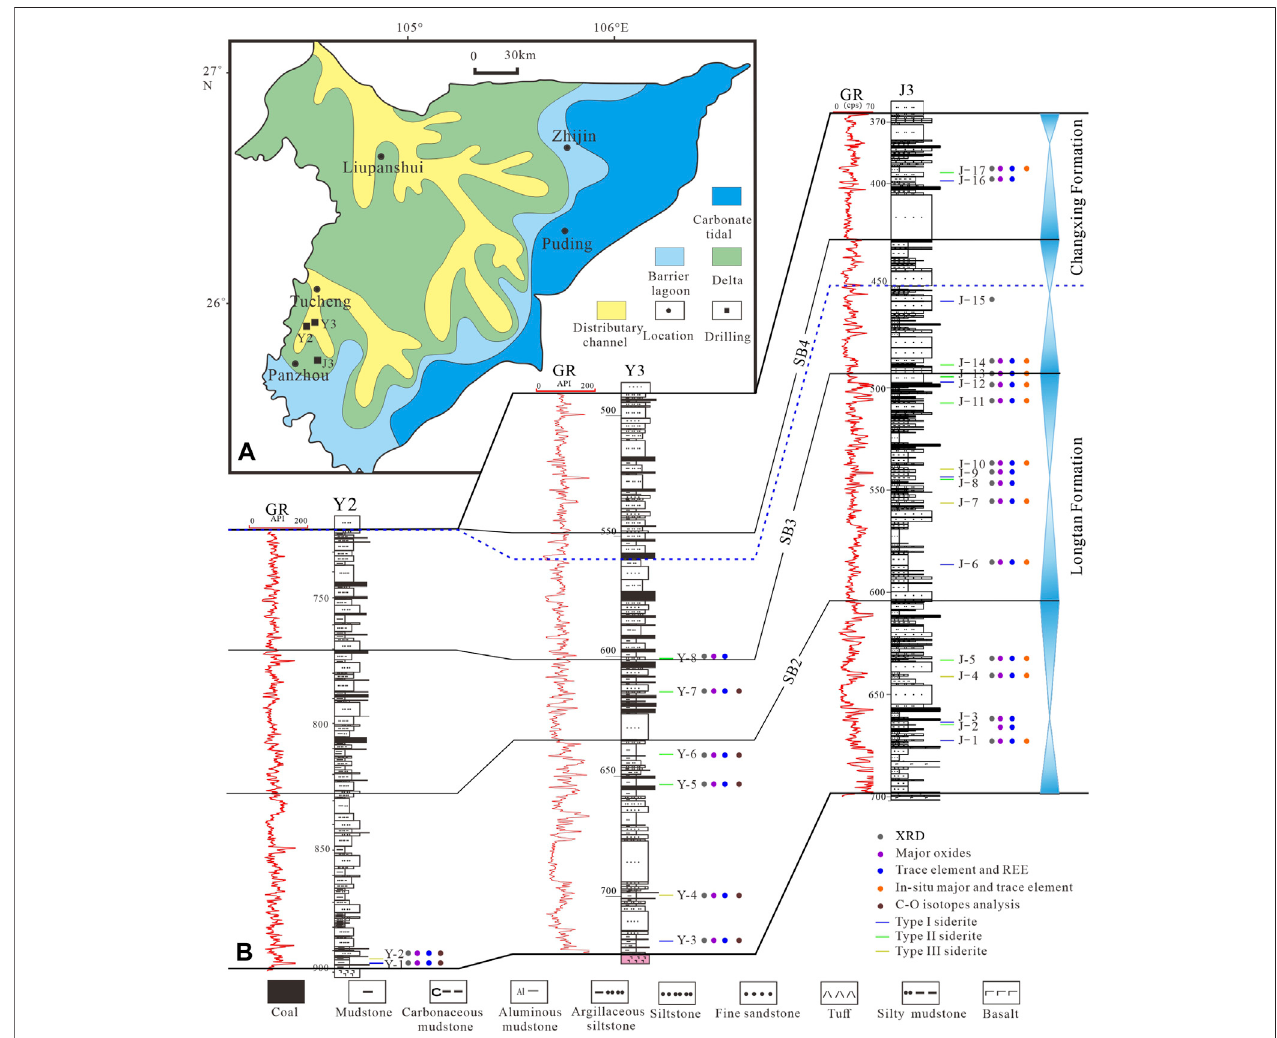
FIGURE 1 | (A) : Lopingian sedimentary system and drillings location in western Guizhou (modi fi ed after Shen et al., 2016). (B) : Strata column, sampling positions, and analytical methods of J3, Y2, and Y3 wells.